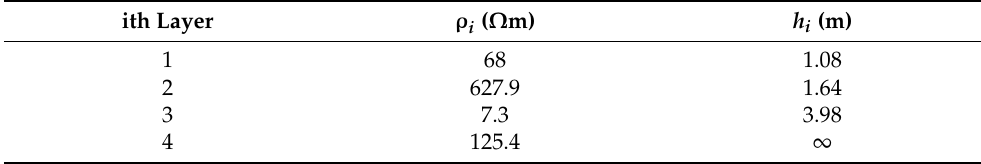
Table 4. Parameters of the four-layer soil structure.